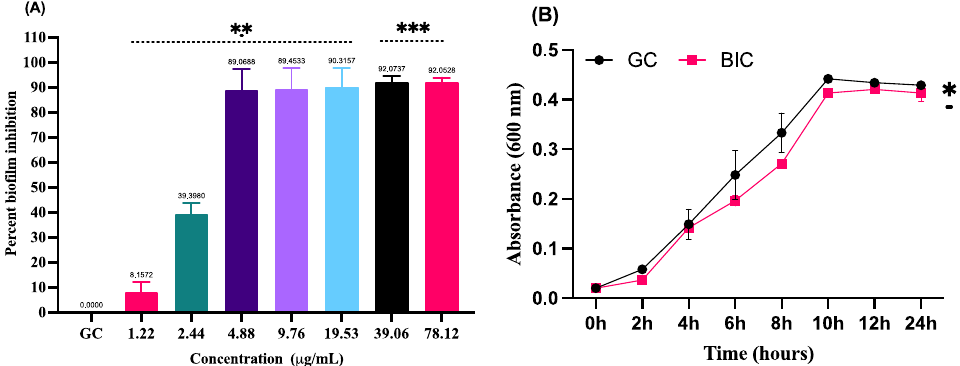
Figure 1. ( A ) Percent biofilm inhibition in S. pyogenes . The inhibition of biofilm formed by S. pyogenes in presence of LME at various concentrations. GC, growth control. *** p value = 0.0002, ** p value = 0.0042. ( B ) Growth curve dynamics. Figure represents the effect of LME (at BIC value) on the growth curve of S. pyogenes . * p value = 0.014.